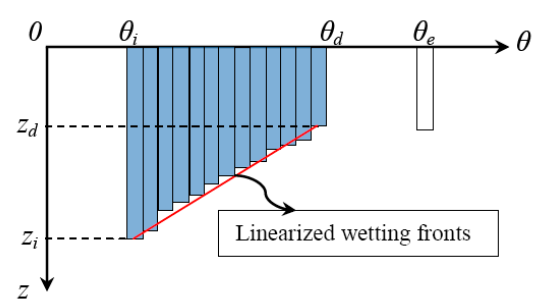
Figure 7. Approximately linearly decaying wetting fronts.